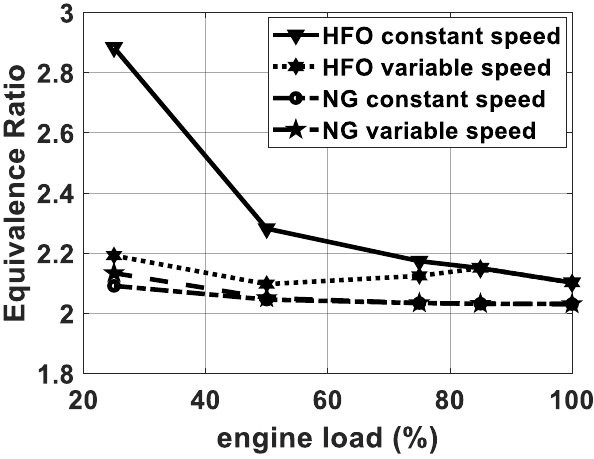
Figure 6. Cylinder equivalence ratio for different fuel types and engine speed